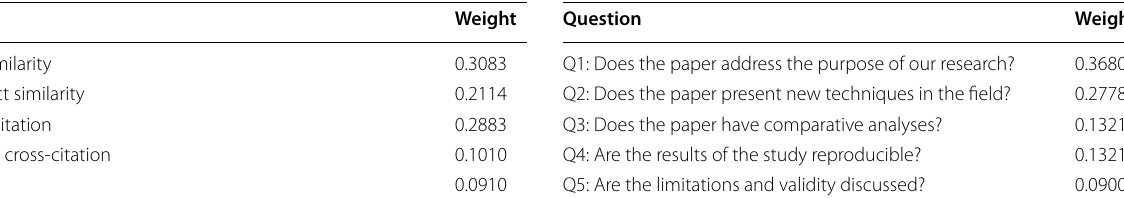
Table 2 Weights for indices of the scoring equation Table 3 Questions for the quality assessment and their